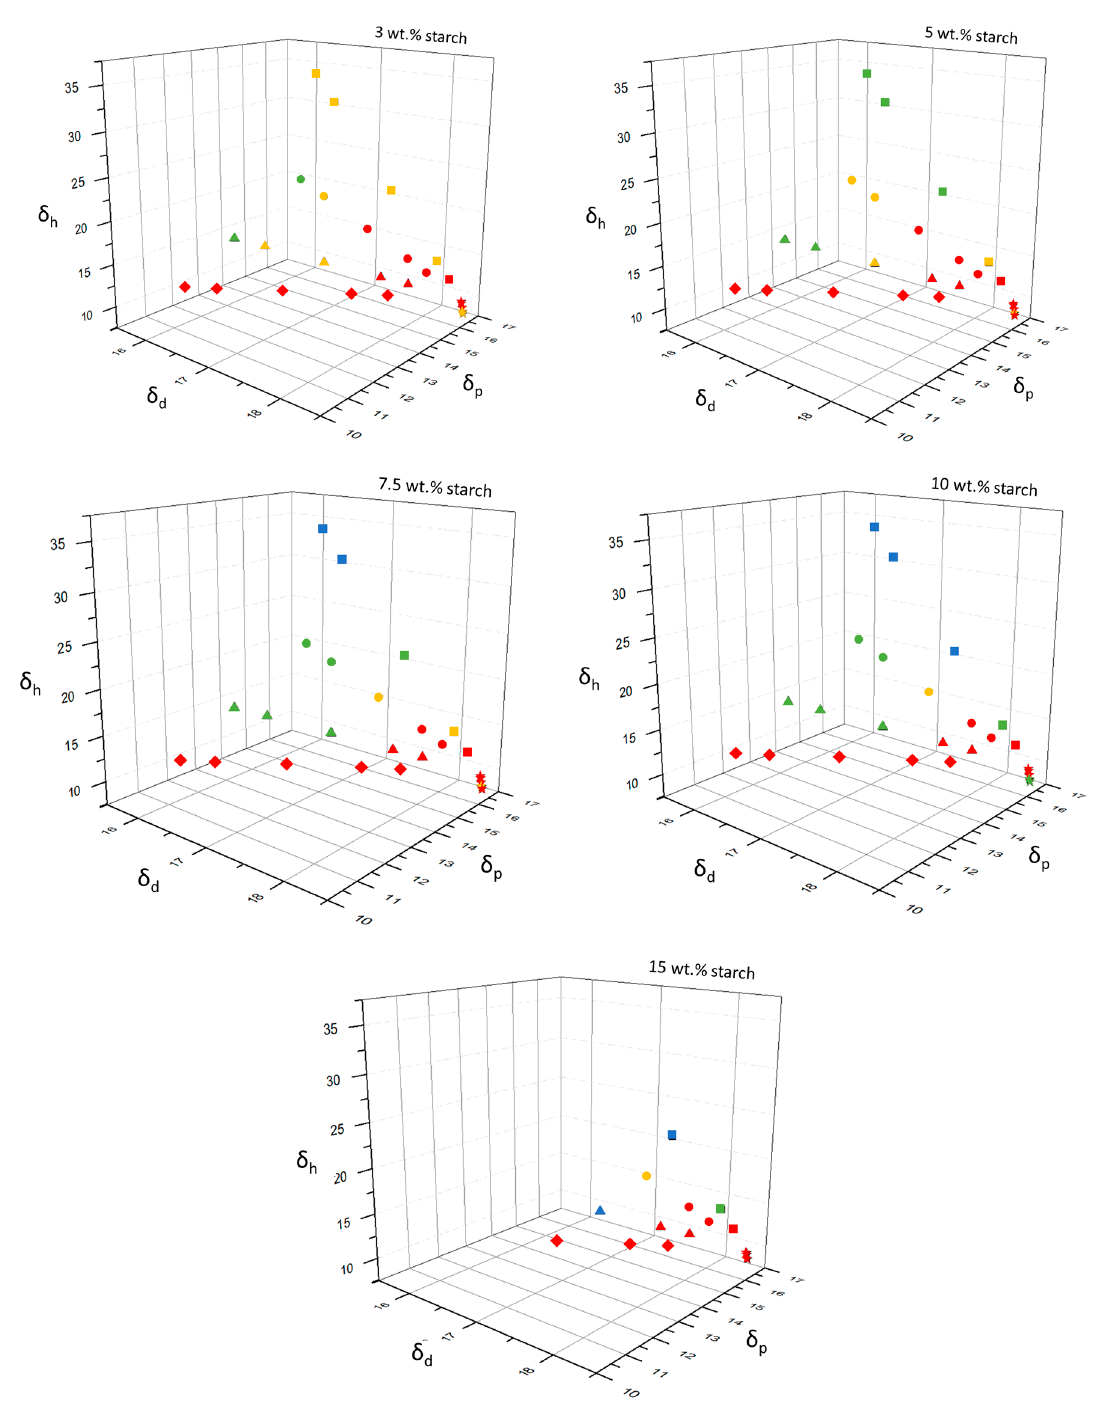
Figure 3. Gelation behavior of starch in various binary mixtures of solvents plotted in 3D Hansen space. The symbols represent the mixtures of DMSO with water ( ● ), propylene glycol ( ■ ), glycerol ( ▲ ), sulfolane ( ★ ), and 2-dimethyl ethanolamine ( ♦ ). The colored symbols represent the gelation behavior of starch, in which: red = liquid; yellow = thick liquid; green = gel-like; blue = strong gel.